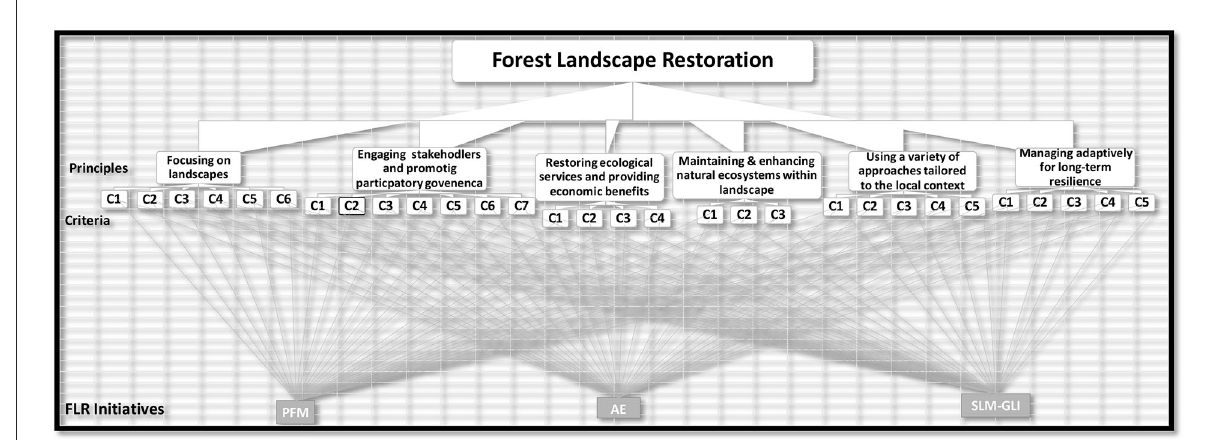
FIGURE2 Map showing the regional states and study sites.